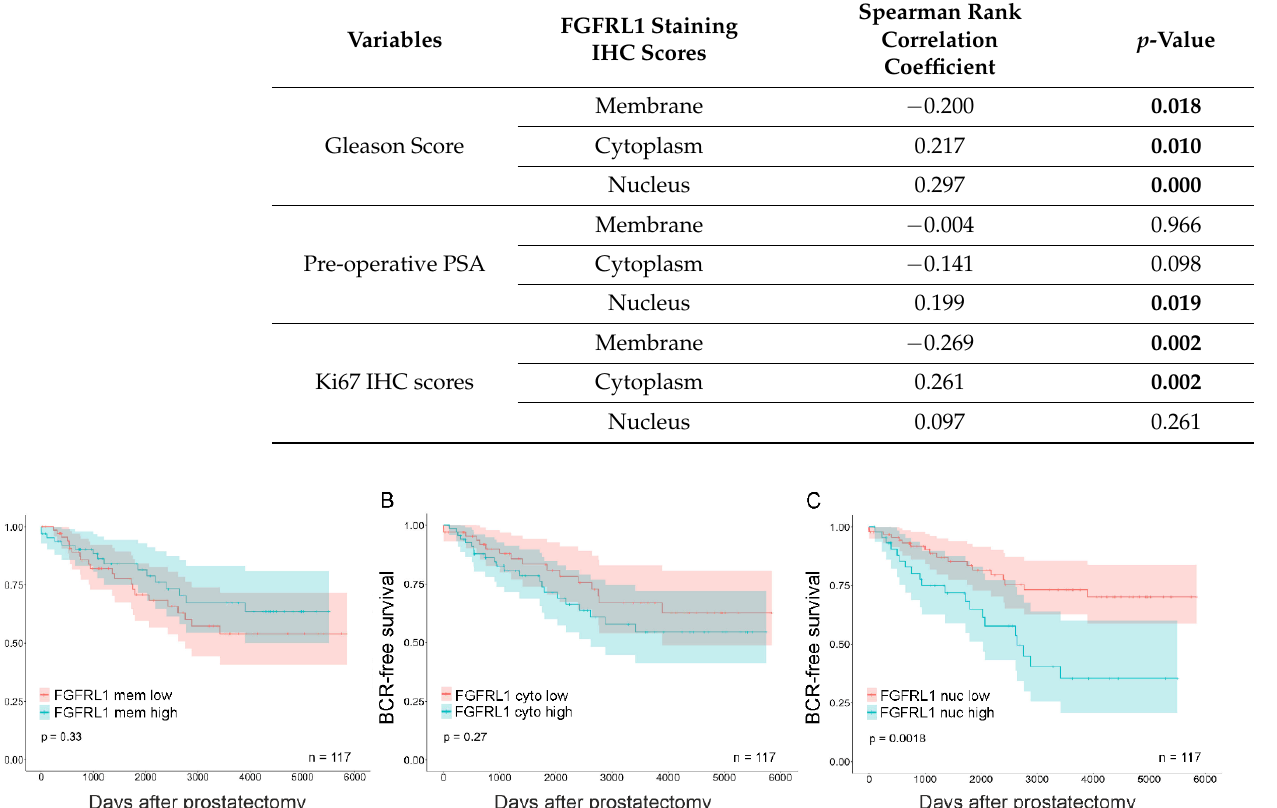
Table 1. Correlation of FGFRL1 staining with the Gleason score, pre-operative PSA, and Ki67 expression (Spearman rank correlation).